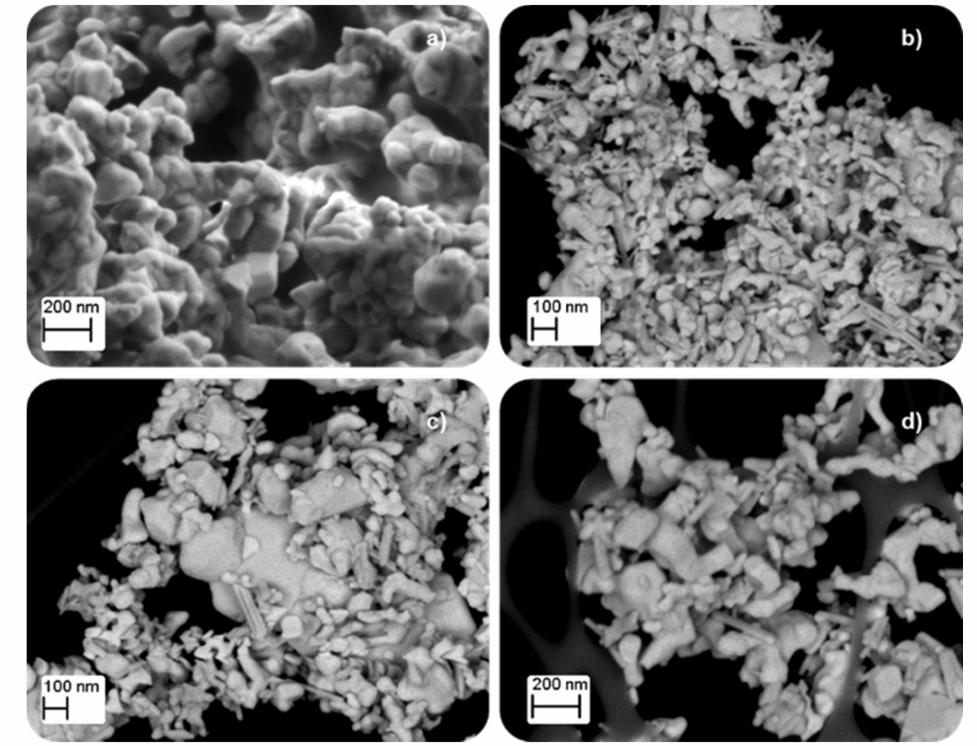
Figure 2. FE-SEM images of ( a ) BM, ( b ) BM-C600, ( c ) BM-C700, and ( d )